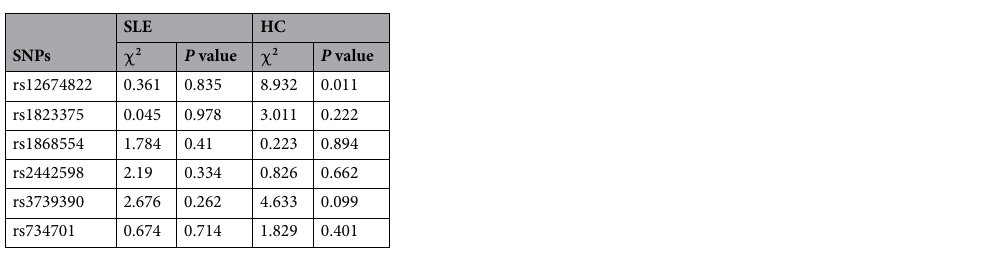
Table 2. The Hardy–Weinberg’s expectation test in SLE patients and healthy controls of six SNPs. SLE, systemic lupus erythematosus; HC, healthy control; SNP, single-nucleotide polymorphisms.